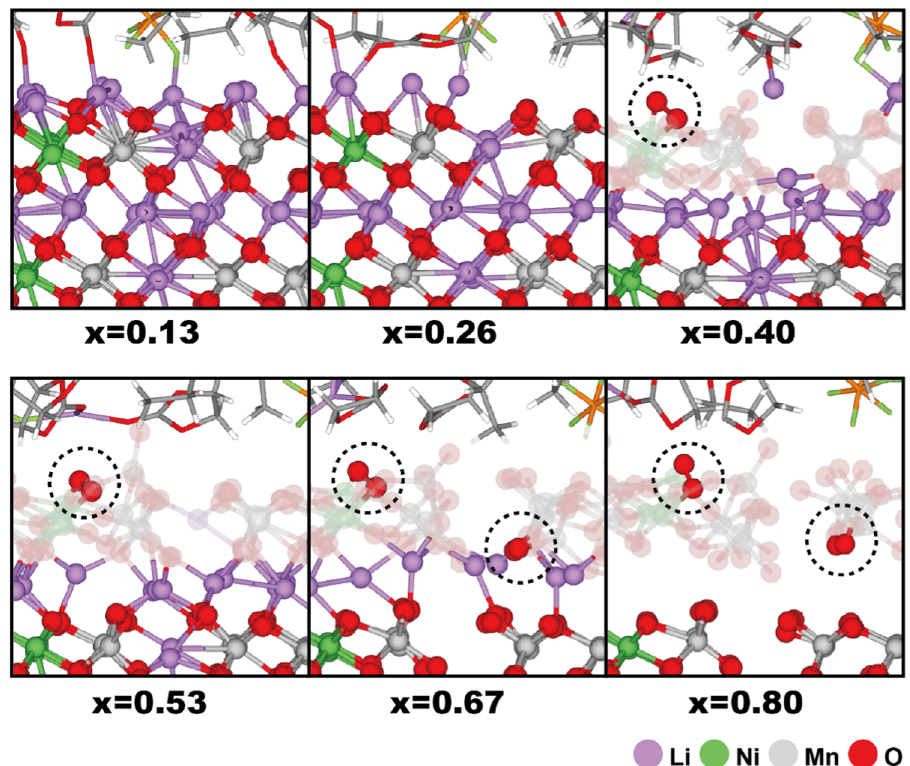
Fig. 2 Optimized con fi gurations for the pristine LNMO system. Side views of snapshot are shown at different delithiation levels (from x = 0.13 to x = 0.8). The black dashed circle represents the position of lattice oxygen on the LNMO